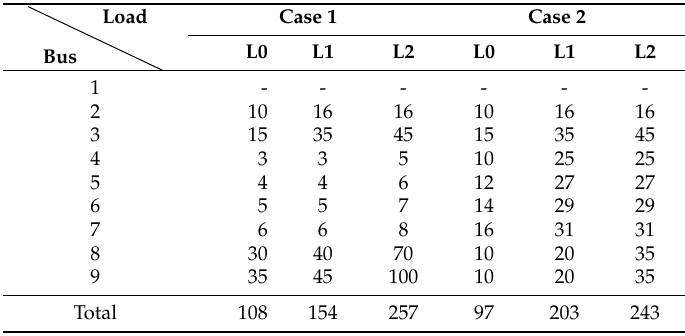
Table 2. Three loading conditions (L0, L1 and L2) for case studies (Unit: kW).